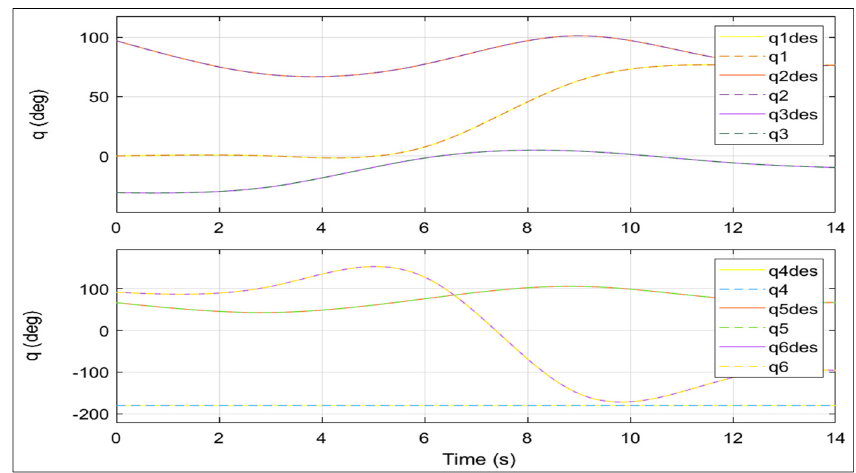
Fig. 11. Joints Trajectory of Step Input / PD+G Controller.